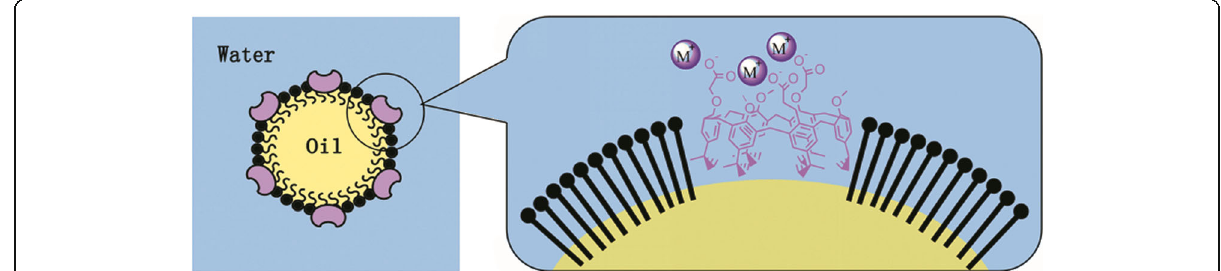
Fig. 3 The structure of calixarene